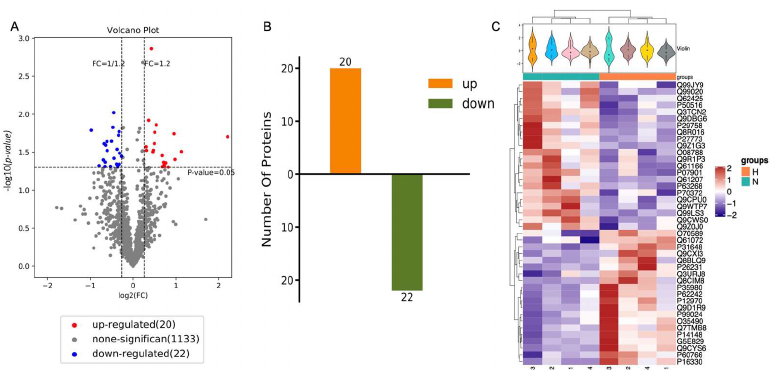
Figure 4. Identification of differentially expressed proteins. ( A ) Volcano differentially expressed proteins of NSC-EVs under normal condition comparing to hypoxic condition. Volcano plot indicates the differentially expressed proteins. Fold change > 1.2 or < 1/1.2 and p < 0.05 is considered to be a significant differentially expressed protein. Red for upregulated proteins, blue for downregulated proteins, and grey for no differentially expressed proteins. ( B ) The number of differentially expressed proteins (N-NSC-EVs vs. HP-NSC-EVs). n = 6. ( C ) Heat maps of identified proteins in N-NSC-EVs and